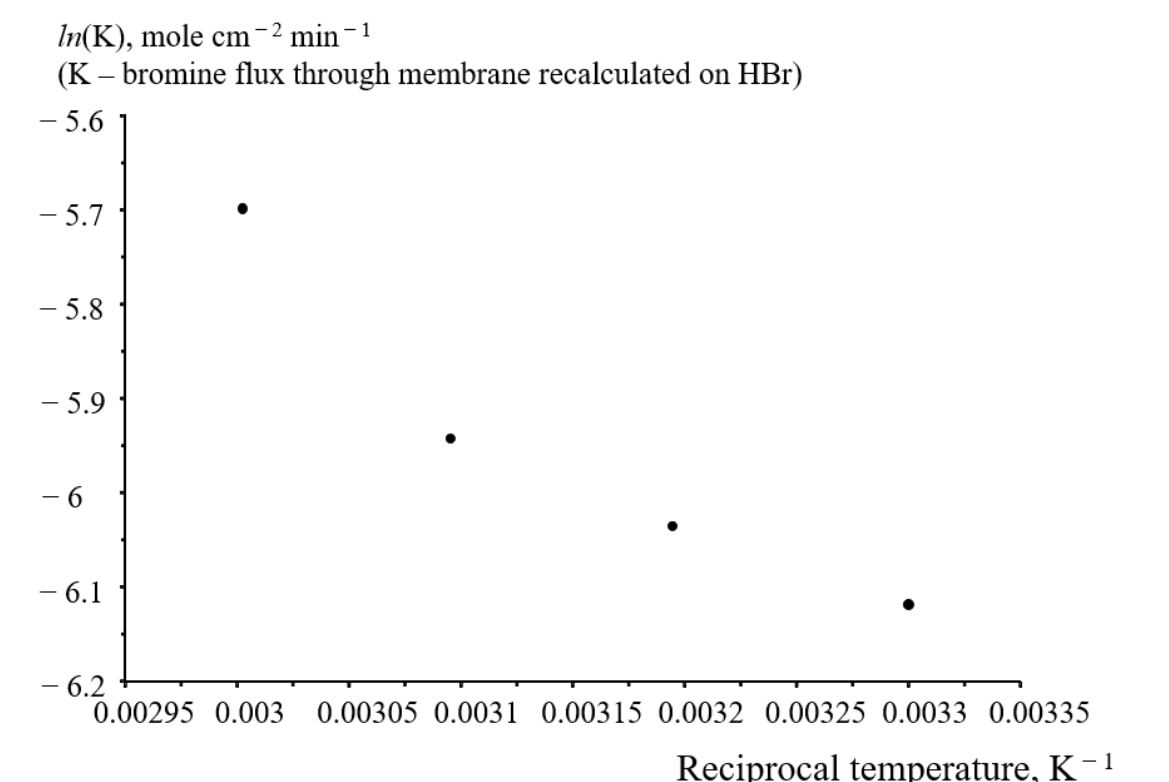
Figure 6. Temperature dependence of the crossover flow of bromine-containing species through the N211 membrane in terms of HBr.